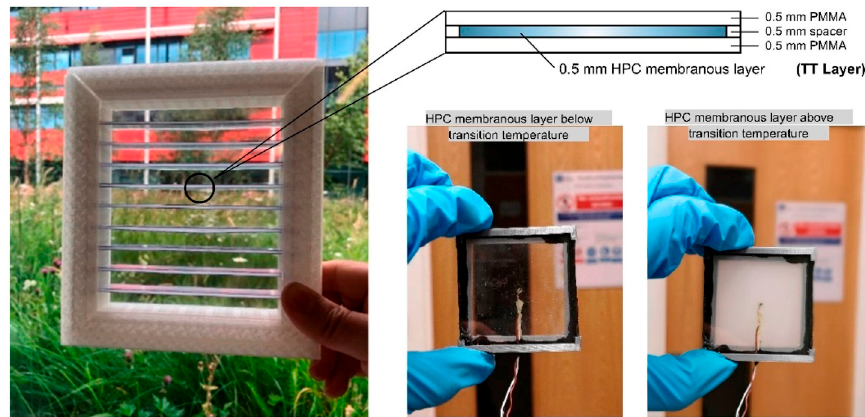
Figure 28. Photos of the DGW-incorporated thermotropic material in clear and translucent states [93].